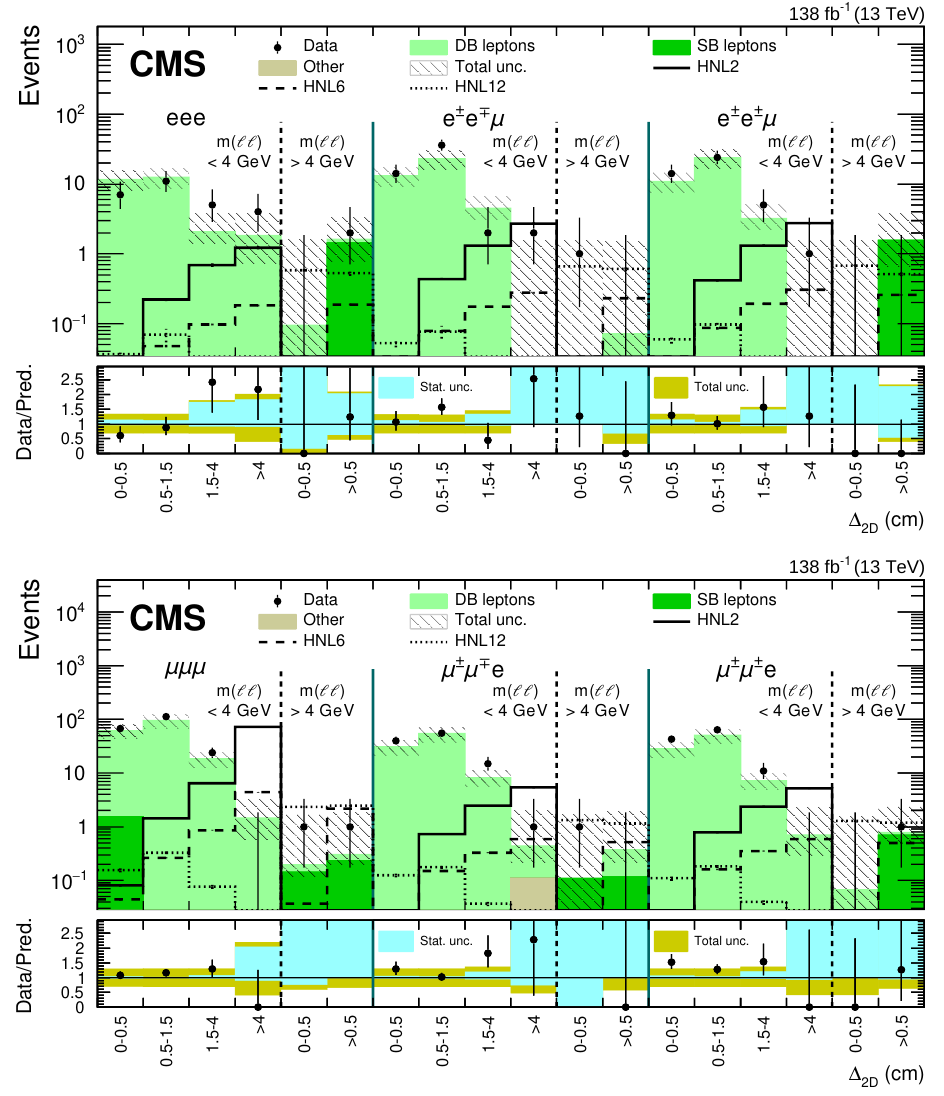
Figure 8 . Comparison between the number of observed events in data and the background pre- dictions (shaded histograms, stacked) in the signal region for eeX (upper) and mm X (lower) final states. The hashed band indicates the total systematic and statistical uncertainty in the back- ground prediction. The lower panels indicate the ratio between data and prediction, and missing points indicate that the ratio lies outside the axis range. Predictions for signal events are shown for several benchmark hypotheses for Majorana HNL production: m = 2 GeV and | V | 2 = 0 . 8 × 10 − 4 N N ‘ (HNL2), m = 6 GeV and | V = 12 GeV and | V | 2 = 1 . 3 × 10 − 6 (HNL6), m | 2 = 1 . 0 × 10 − 6 N N ‘ N N ‘ (HNL12). The uncertainty band assigned to the background prediction includes statistical and systematic contributions. Small contributions from background processes that are estimated from simulation are collectively referred to as